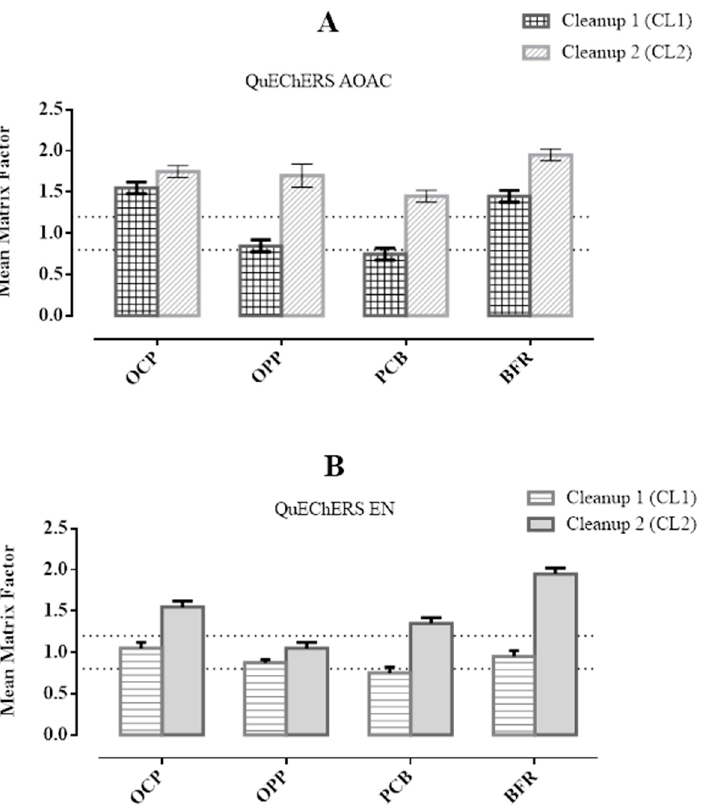
Figure 5. Matrix factor results for the chemical families studied using QuEChERS AOAC ( A ) and EN ( B